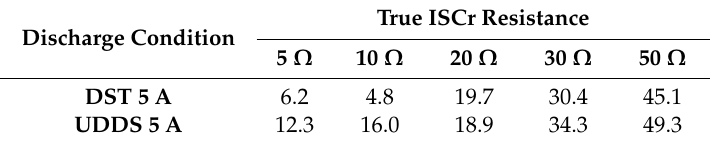
Table 5. Relative error (%) of the final value of R ISCf depending on the ISCr faults in the experiment with cell A.